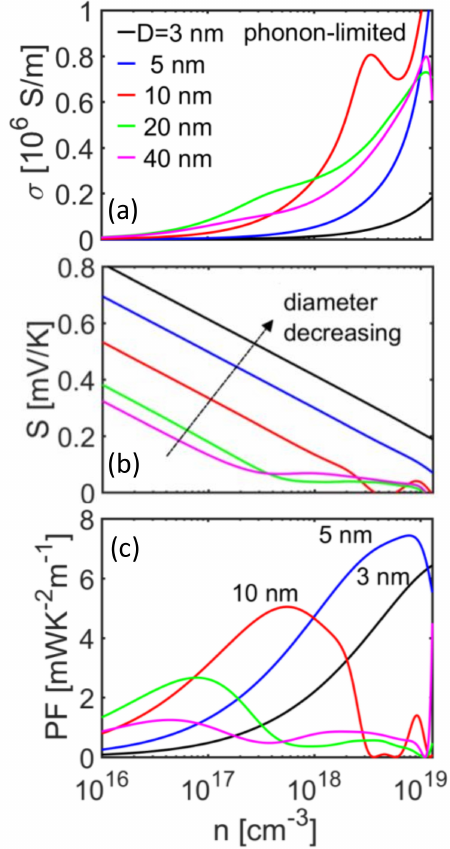
Figure 4. Thermoelectric coe ffi cients under phonon scattering-limited transport conditions at room temperature for [100] InAs with di ff erent diameters, as indicated in the figure. ( a ) Electrical conductivity, ( b ) Seebeck coe ffi cient, and ( c ) power factor versus carrier concentration. As the diameter is reduced, the Seebeck coe ffi cient is increased. The power factor is increased for the smaller NW diameters around d ~ 3–10